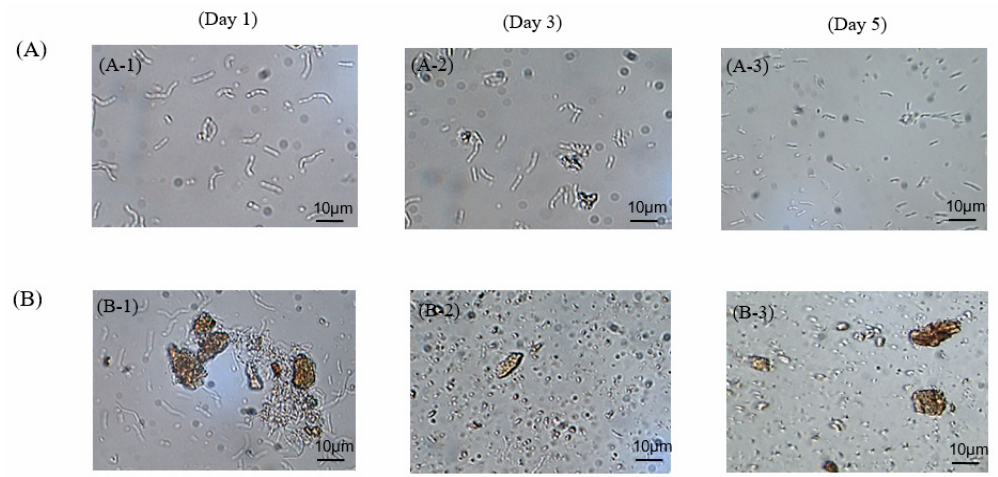
Figure 5. Optical microscopy images of B. subtilis ATCC 21332 growth, taken after various numbers of cultivation days; ( A ) in the absence of any LDH; ( B ) in the presence of Mg 2 Fe–LDH.